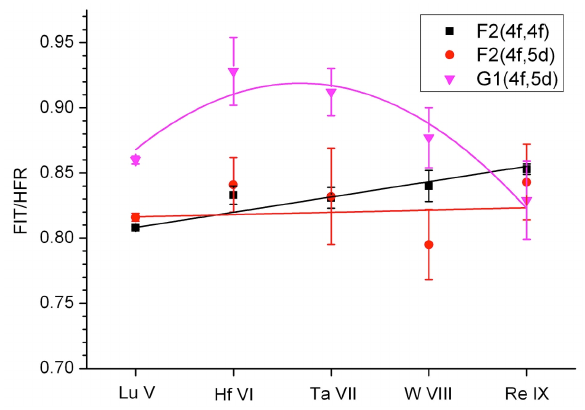
Figure 6. Scaling factors for main electrostatic parameters in the 4f 12 5p 6 5d configuration.